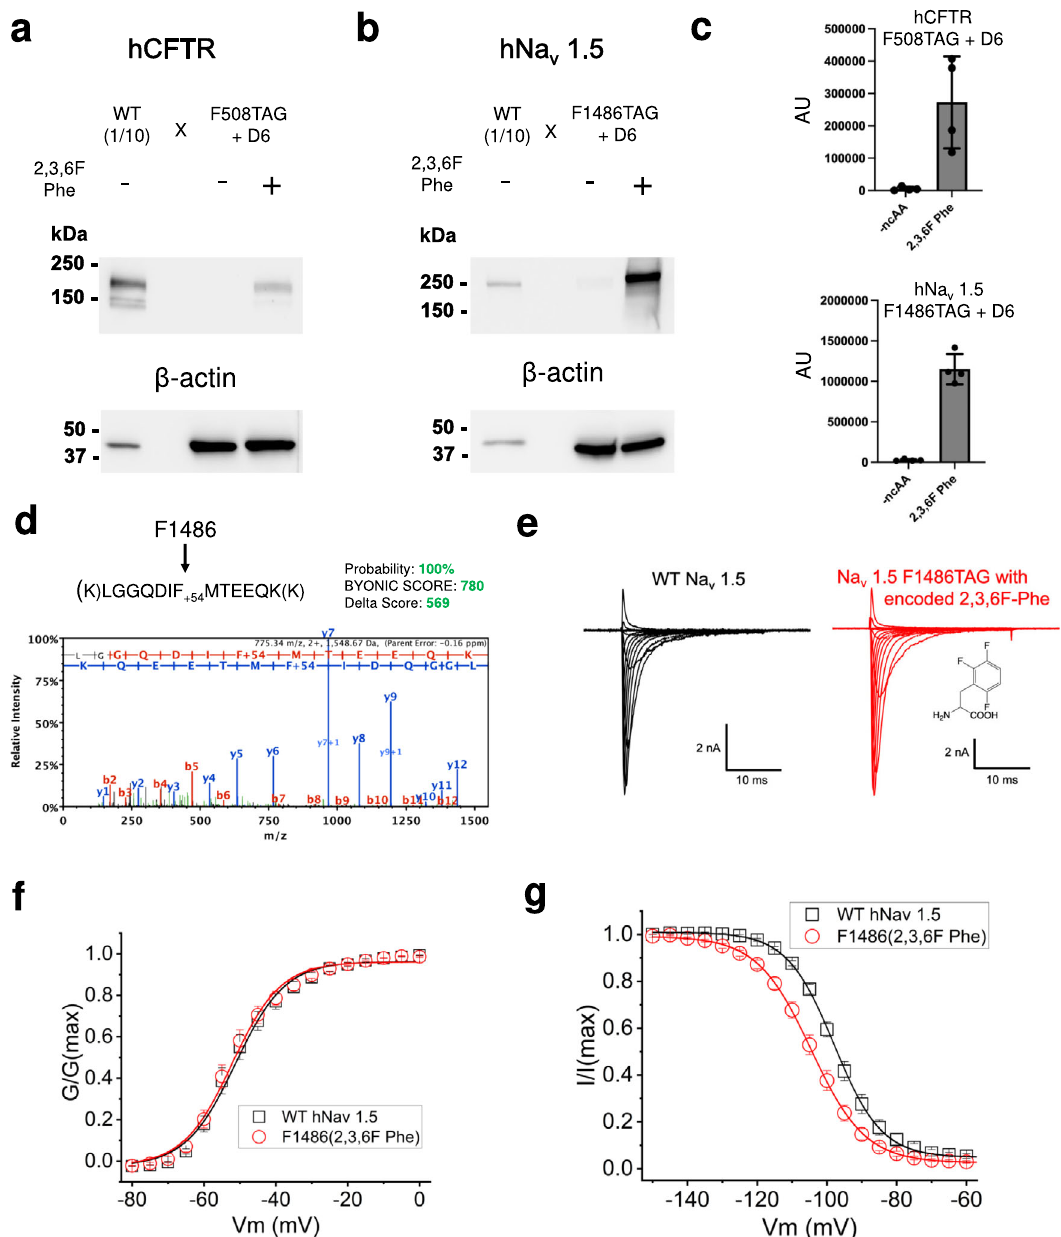
Fig. 7 | Site-speci fi c encoding of tri- fl uoro-Phe within two large, human ion channels.a Westernblot ofhCFTR using C terminal antibody(ab596) of WT CFTR or F508TAG-CFTR co-transfectedwith Phe X-D6 in the presenceor absence of 2mM 2,3,6F Phe. WT lysates are loaded at 1:10 of TAG conditions. Uncropped blots are shown in the Supplementary Information fi le. b Western blot of hNa V 1.5 using C terminal antibody (D9J7S)of WT hNa V 1.5 or F1486TAG-hNa v 1.5 co-transfected with Phe X-D6 inthepresenceorabsenceof2mM2,3,6FPhe.Imagesarerepresentativeof four individual blots. Uncropped blots are shown in the Supplementary Informa- tion fi le. c Quanti fi cation (densitometry) of signal from 60 µ g of the loaded lysate